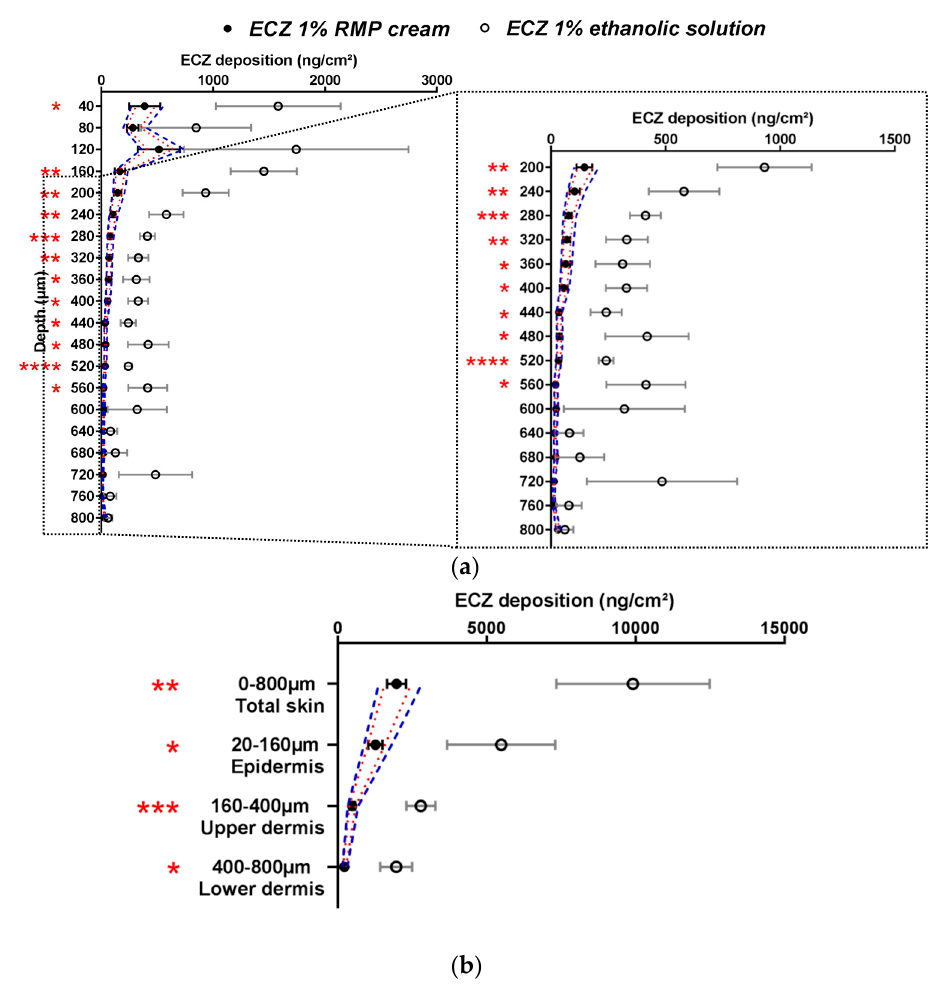
Figure 2. Cutaneous biodistribution profile of ECZ: ( a ) in porcine skin lamellae (2 × 20 µm + 19 × 40 µm) to 800 µm (full depth) and ( b ) as a function of position in the anatomical regions of the skin (epidermis, upper and lower dermis) and in total skin. Tested groups: reference medical product (ECZ 1% RMP cream) ( ) and non-bioequivalent “negative control” (ECZ 1% ethanolic solution) ( ). (Mean ± CI 90% ; n = 12 and n = 6, respectively). Intervals of acceptance criteria were calculated based on the mean ECZ deposition from the RMP; ( ) interval of 80.00–125.00% and ( ) interval of 69.84–143.19%. P -values were calculated using a Student’s t test; statistically significant differences are denoted by asterisks (* p < 0.05; ** p < 0.005; *** p < 0.0005; **** p < 0.00005).